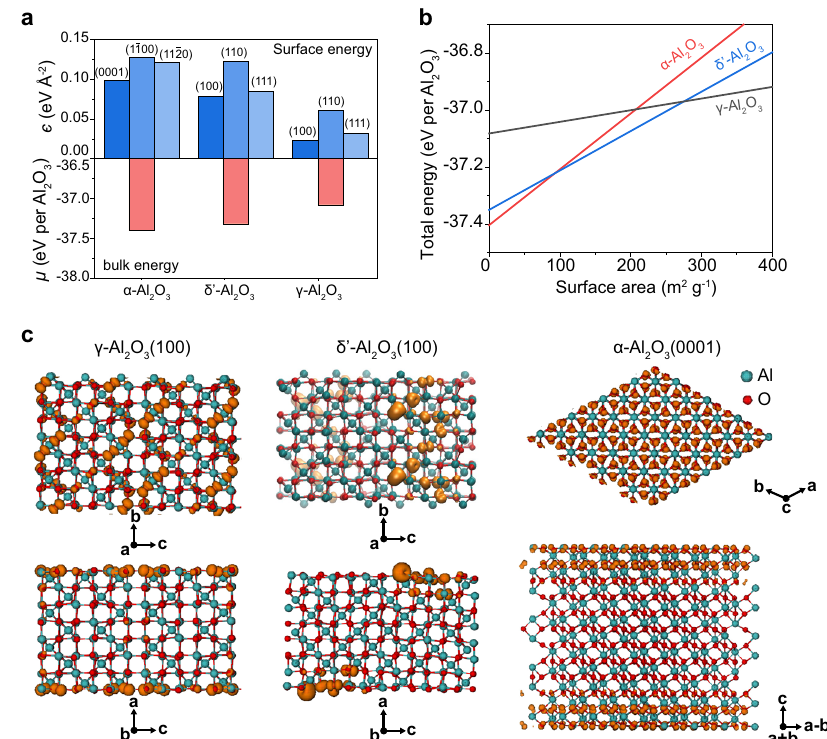
Fig. 4 | Topotactic phase transformation process revealed by density func- tional theory (DFT) calculations. a The bulk energies ( μ , eV per Al 2 O 3 ) and the surface energies ( є , eV Å – 2 ) of representative crystal surfaces for the three Al 2 O 3 phases. The δ ʹ -Al 2 O 3 and α -Al 2 O 3 phases are anhydrous and the γ -Al 2 O 3 phase is hydroxylated with 2 OHnm – 2 . b The total energy (the sum of bulk energy and